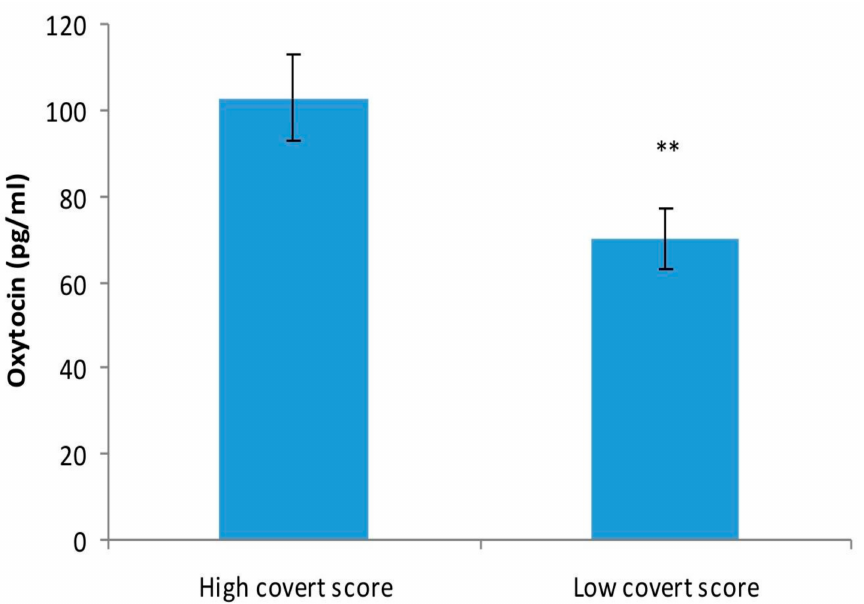
Figure 2. Oxytocin level (pg/mL) in patients with a higher level of covert aggression and patients with a lower covert aggression score, as studied by two-tailed, unpaired Student’s t -test. The values are mean ± S.D. ( n = 14 per group). ** p =